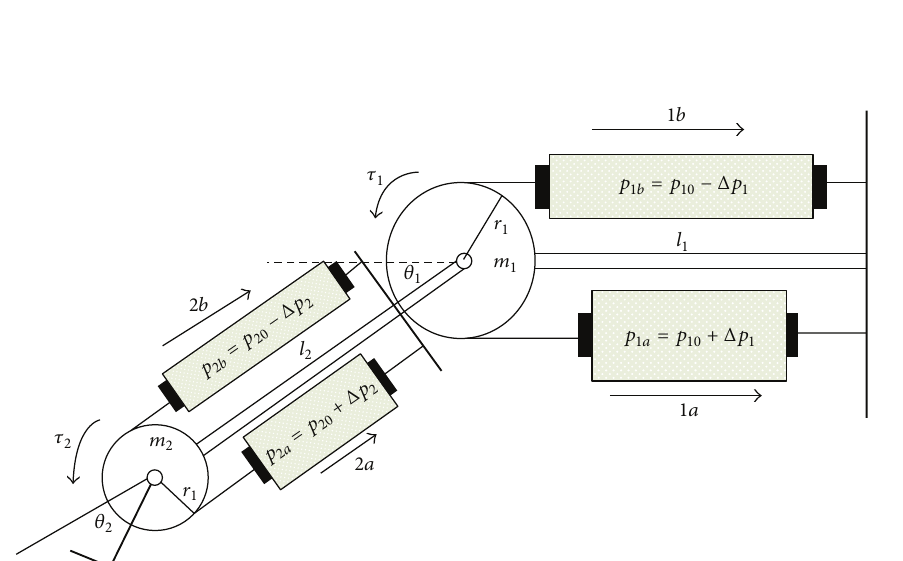
Figure 1: The experimental setup.